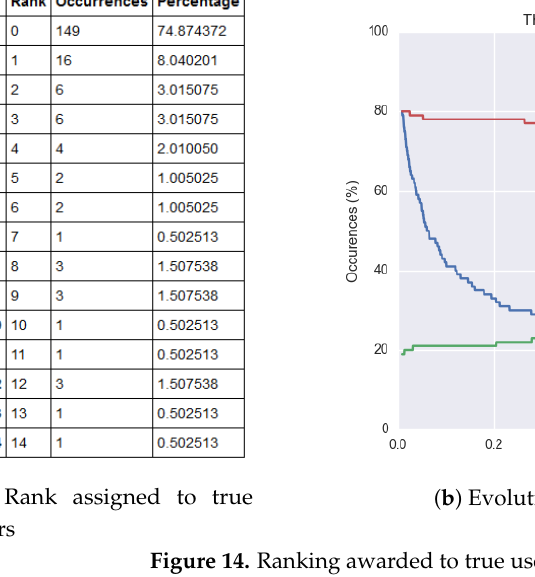
Figure 14. Ranking awarded to true user during Gaussian NB